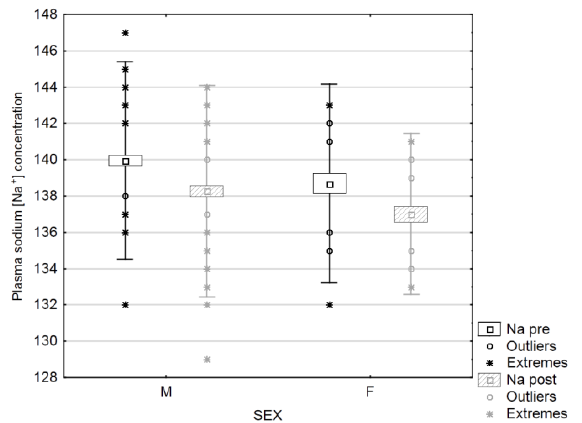
Histogram of age categorized by sex ( N =